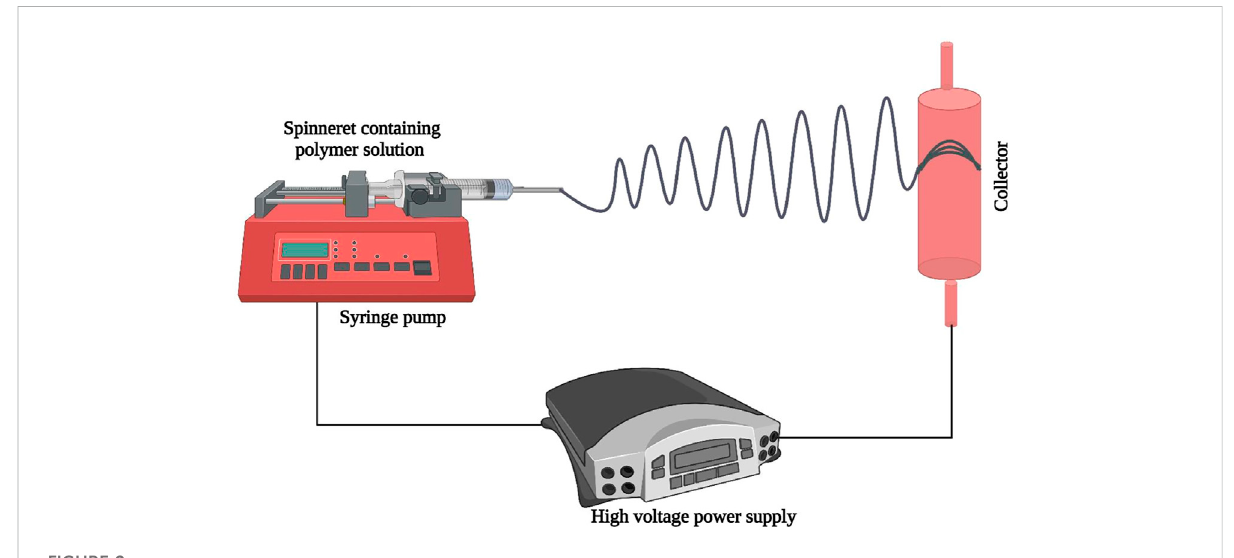
FIGURE 2 An overview of electrospinning